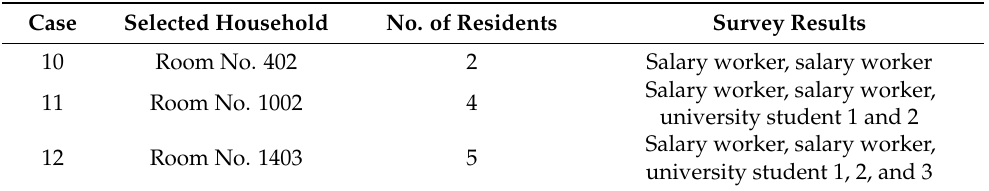
Table 14. Survey results of residents consuming less than the average heating energy.